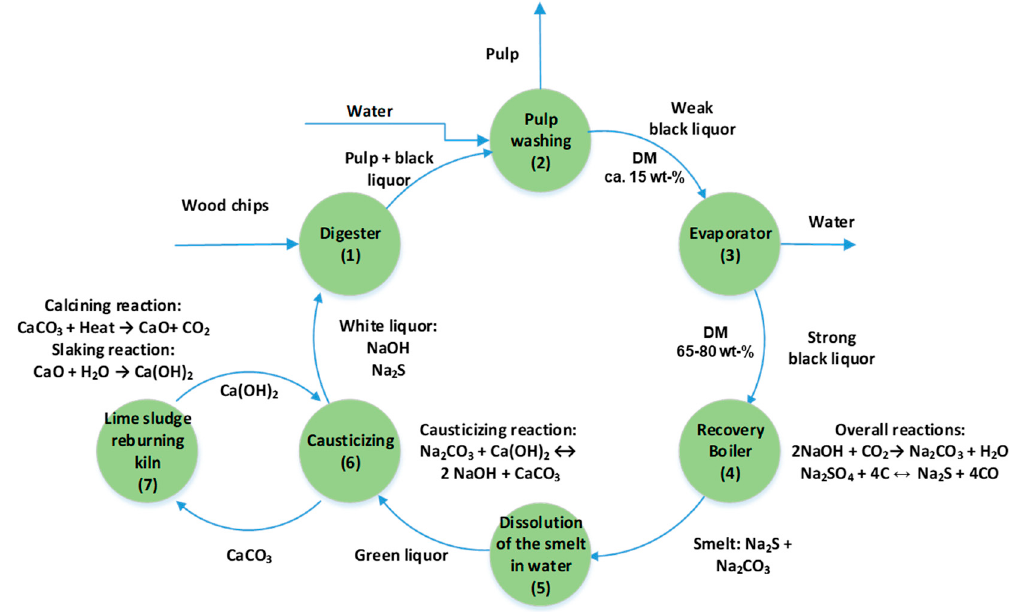
Figure 1. The main material flows in a Kraft pulp mill process. ( DM = Dry Matter). The figure is redrawn from Biermann [33].